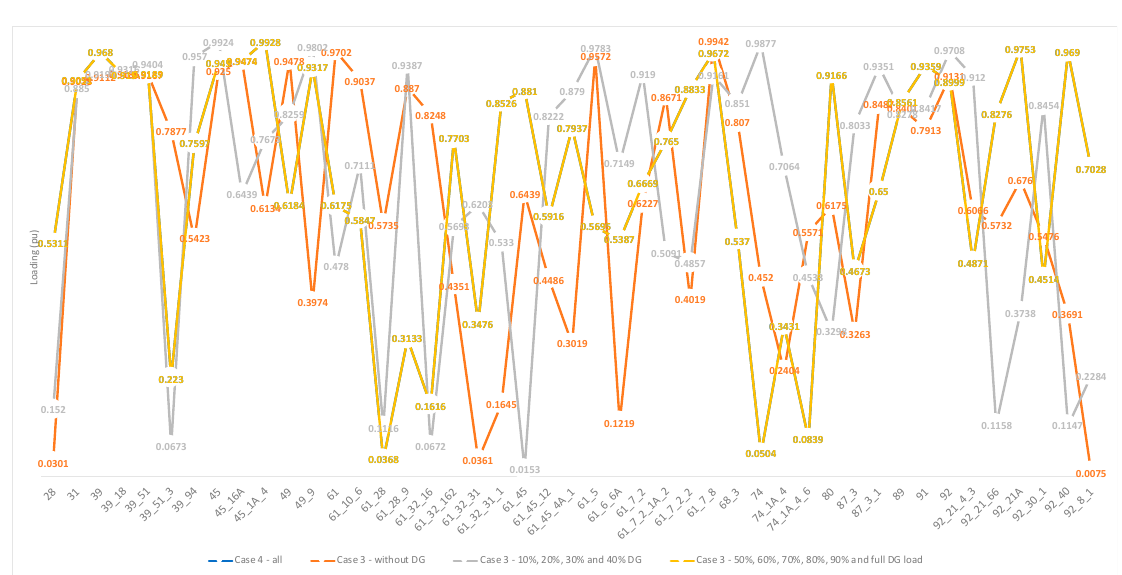
Figure 6. Loading per node for cases 3 and 4.